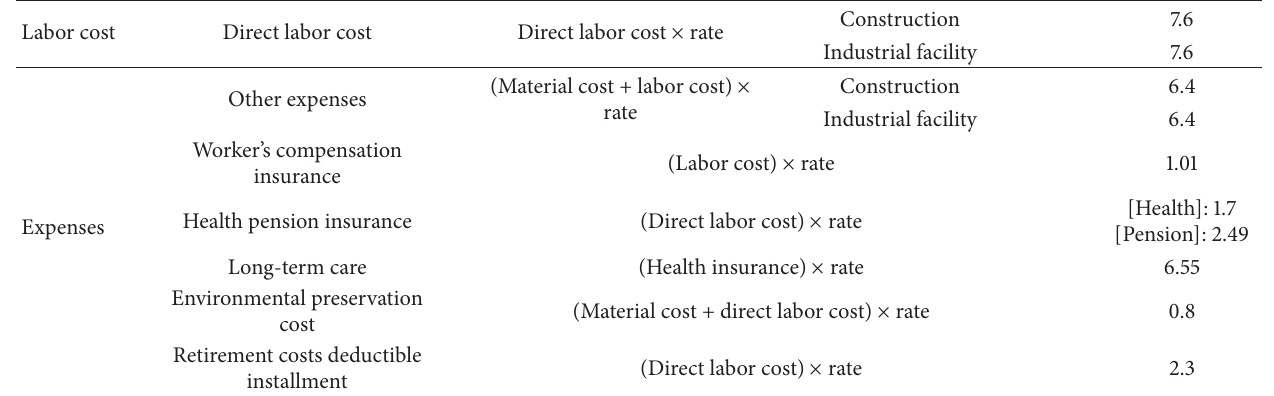
Table 3: Method for calculating the investment costs DB for an economic